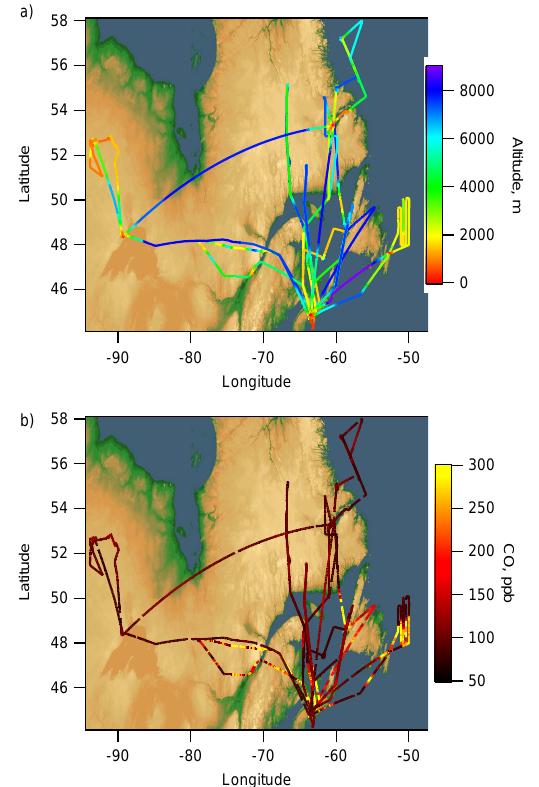
Fig. 1. The geographic coverage of flights during BORTAS, 12 July to 3 August, 2011 (excluding the Atlantic transits) colour-coded by (a) altitude and (b) CO as a marker for